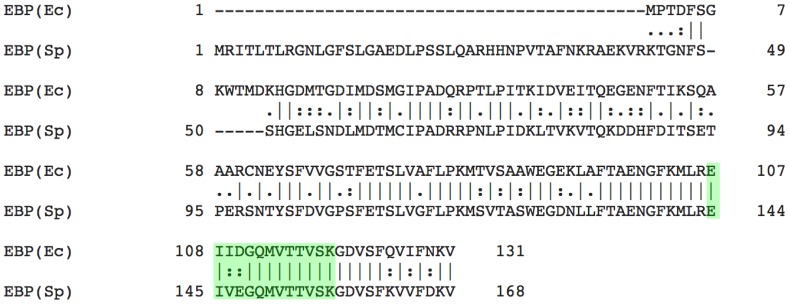
Global pairwise alignment of EBP(Ec) and EBP(Sp) amino acid sequences.A global pairwise alignment of EBP(Sp) and EBP(Ec) amino acid sequences was performed using EMBOSS Needle. The peptide sequence derived by mass spectrometry of an in-gel digest of EBP(Ec) is highlighted in green.